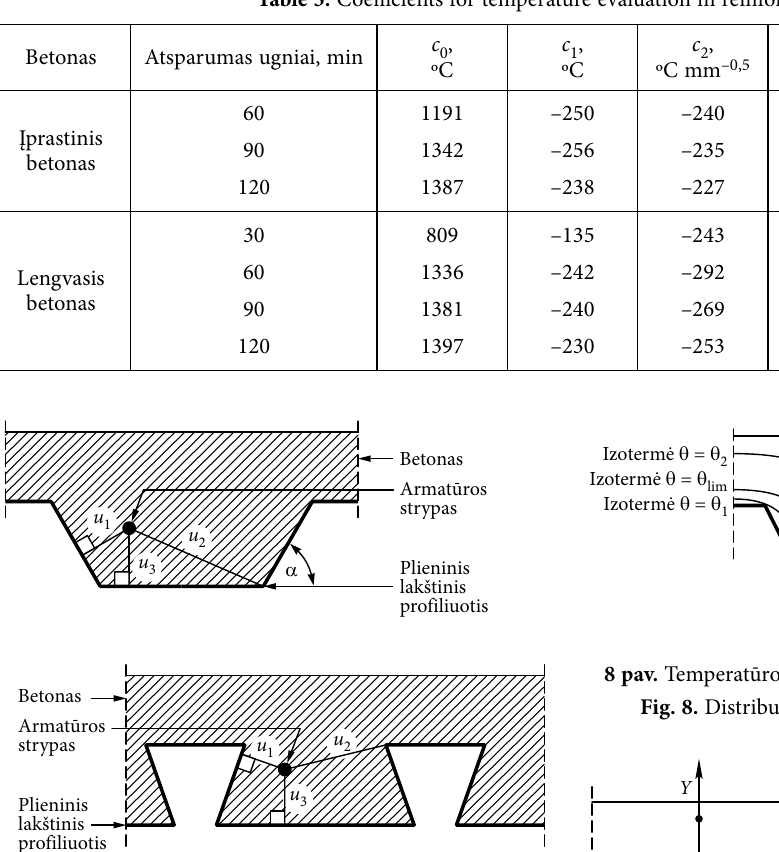
7 pav. Armatūros strypų padėties rodikliai Fig. 7. The standing index of reinforcement bars